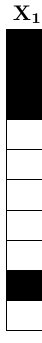
Figure 1. Illustration of a design matrix with missing values (black cells) in a regression model. X 1 to X 4 correspond to variables in the model, and rows depict